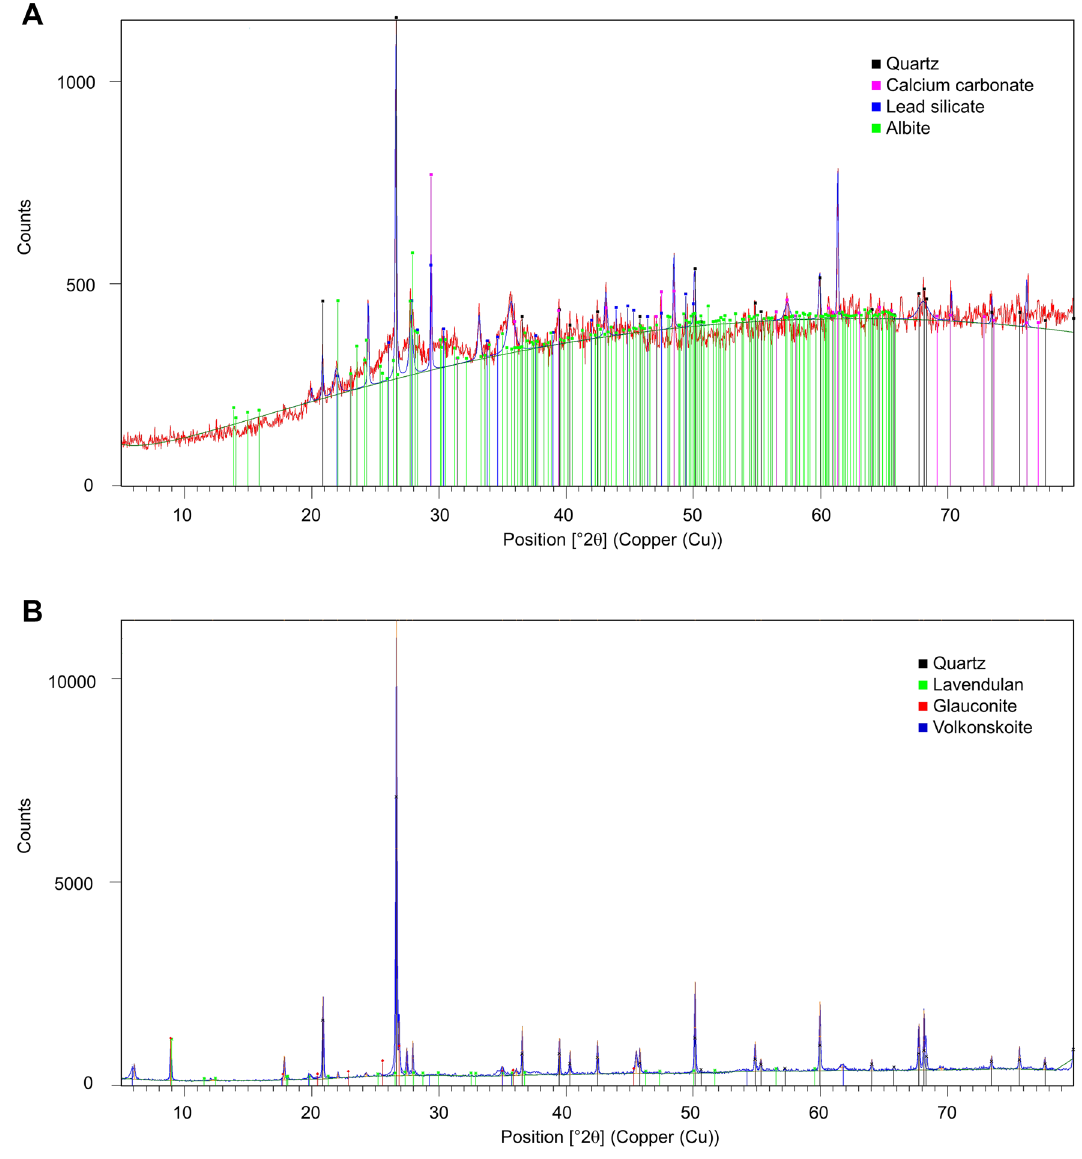
Figure 1. Diffractograms of CAFAS ( A ) and cave sediment ( B